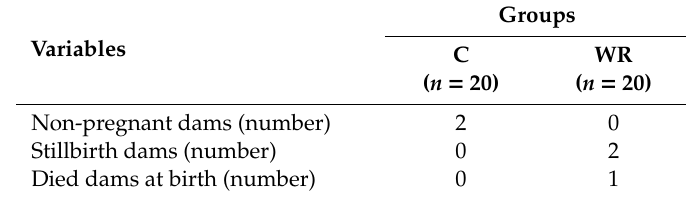
Table 1. Summary related to dams at the end of gestation period in each experimental group.